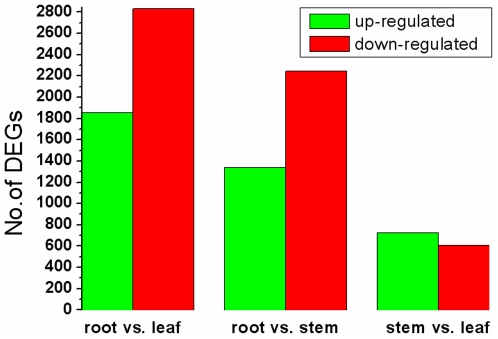
Changes in gene expression profile among the different Taxus tissues.The number of up-regulated and down-regulated genes between root and leaf, root and stem, and stem and leaf are summarized. For example, “1,854” means that the expression of 1,854 genes is statistically significantly higher in the leaf than in the root; “2,830” means that the expression of 2,830 genes is statistically significantly lower in the leaf than in the root.